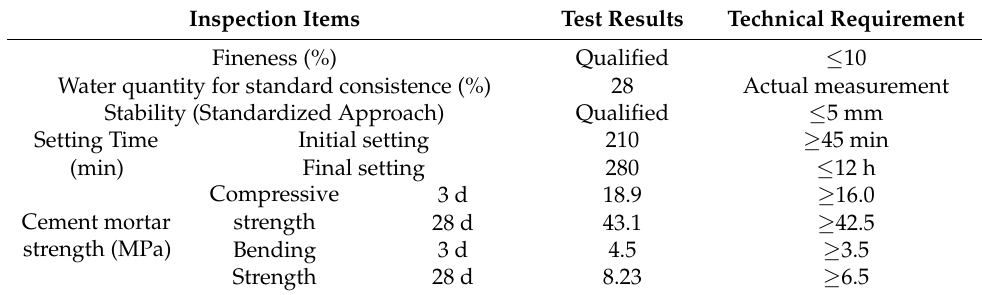
Table 1. Physical properties of cement used.